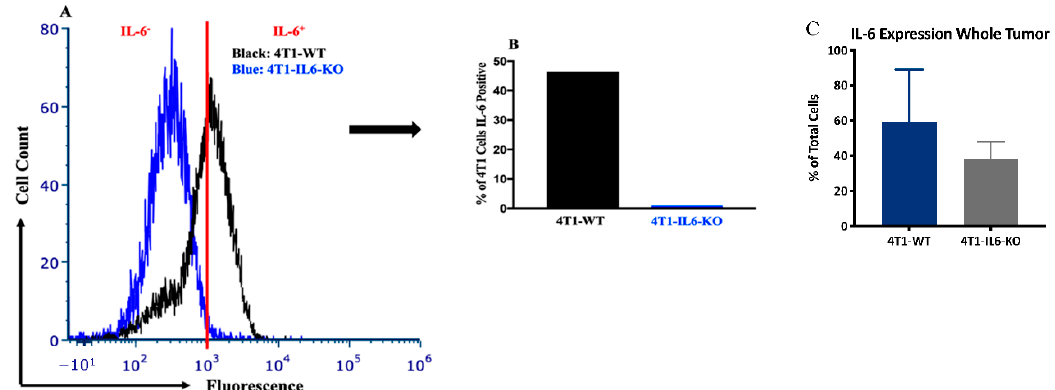
Figure 7. CRISPR/Cas9 knockout of IL-6 in the 4T1 cell line. Wild type 4T1 (4T1-WT) vs. IL-6 knock out 4T1 (4T1-IL6-KO) expression of IL-6 via intracellular flow cytometry. ( A ) Histogram demonstrating relative fluorescence, and ( B ) percentage of total 4T1 that are IL-6 positive. ( C ) Total cells positive for IL-6 in tumors grown from 4T1-WT and 4T1-IL6-KO lines. Background IL-6 positivity in KO tumors likely derives from tumor-associated stromal cells.